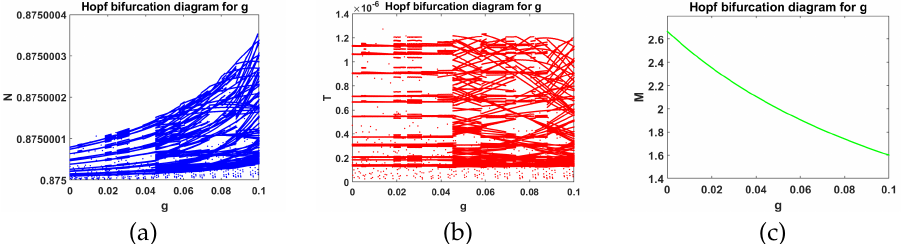
Figure 6. The emergence of Hopf bifurcation at E 3 for normal cells N, tumor cells T, and immune cells M, respectively, with respect to glucose parameter g where g ∈ ( 0,0.1 ) . ( a ) The effect of glucose on the normal cells. ( b ) The effect of glucose on the tumour cells. ( c ) The effect of glucose on the immune